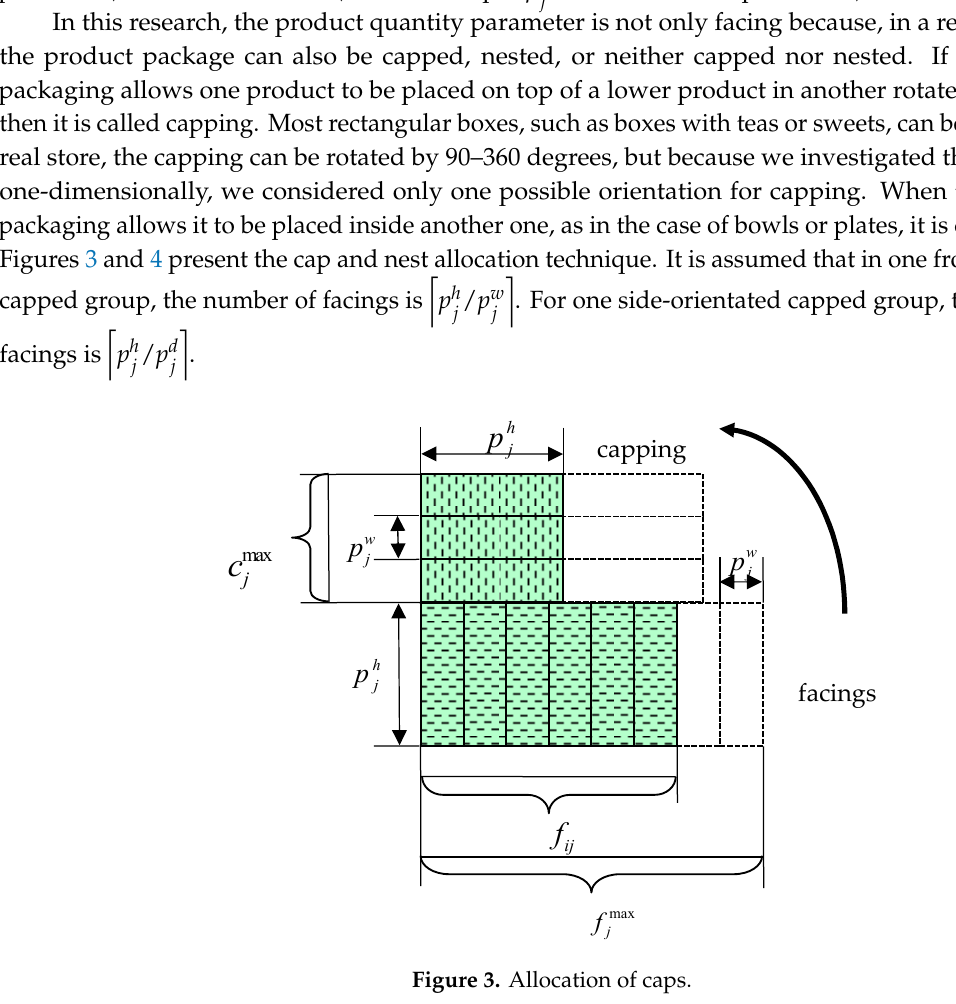
Figure 4. Allocation of nests. The allocation is one-dimensional, so the following assumptions are introduced. 1.